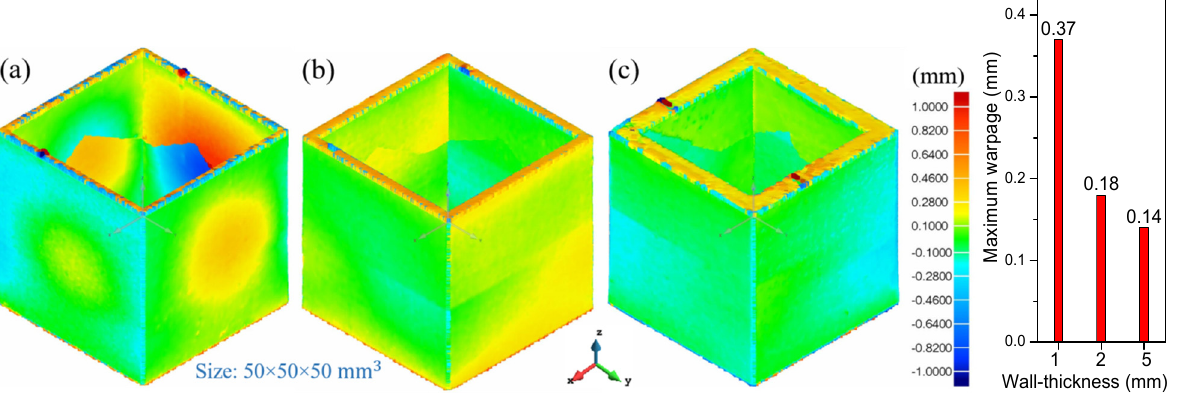
Figure 7. Contour-fills of the final warpage of the square thin-wall section with different wall-thicknesses: ( a ) 1 mm; ( b ) 2 mm; ( c ) 5 mm, respectively. ( d ) Maximum warpages recorded in the middle